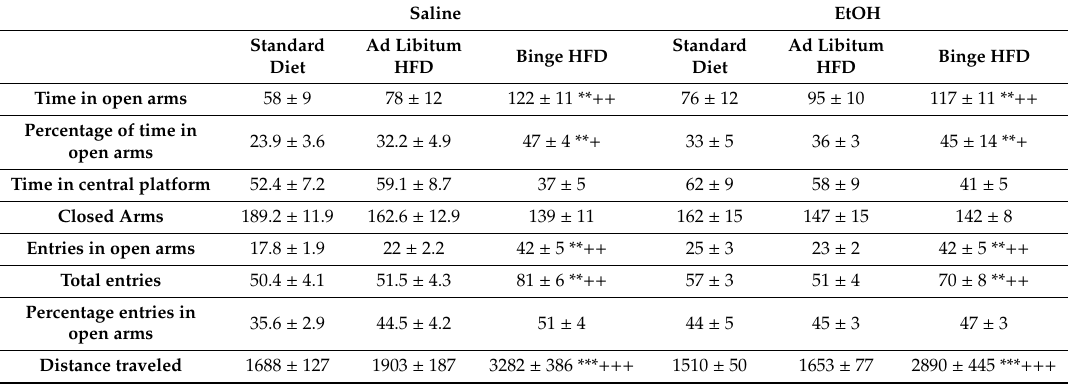
Table 2. Elevated plus maze. Data are presented as mean ( ± SEM), *** p < 0.001; ** p < 0.01 versus standard diet; + p < 0.05; ++ p < 0.01; +++ p < 0.001 versus high-fat diet.